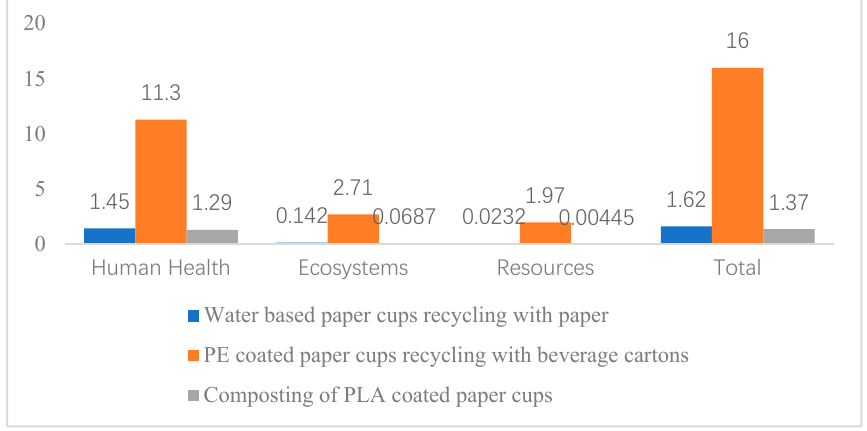
Figure 5. Single score results of three paper cup scenarios (S1, S2, and S3).